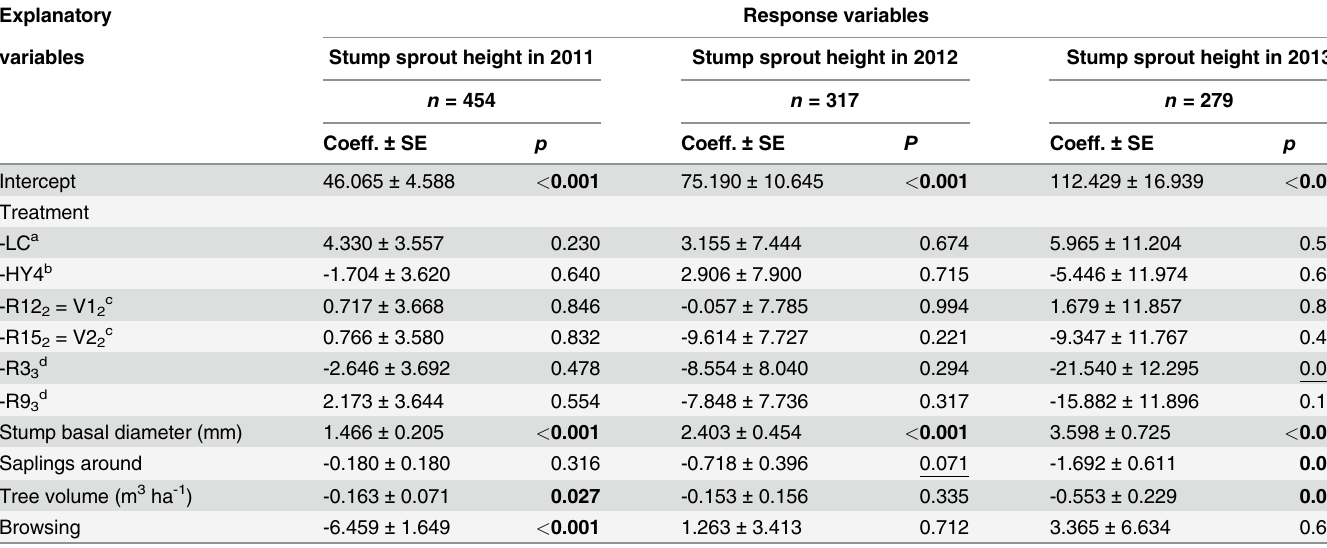
Table 6. Differences in the Height of Stump Sprouts of Living Birches between the C . purpureum Strain R5 3 and Other